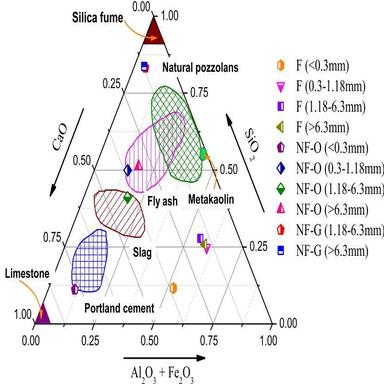
CaO-SiO2-Al2O3 ternary diagram of classified IBA.